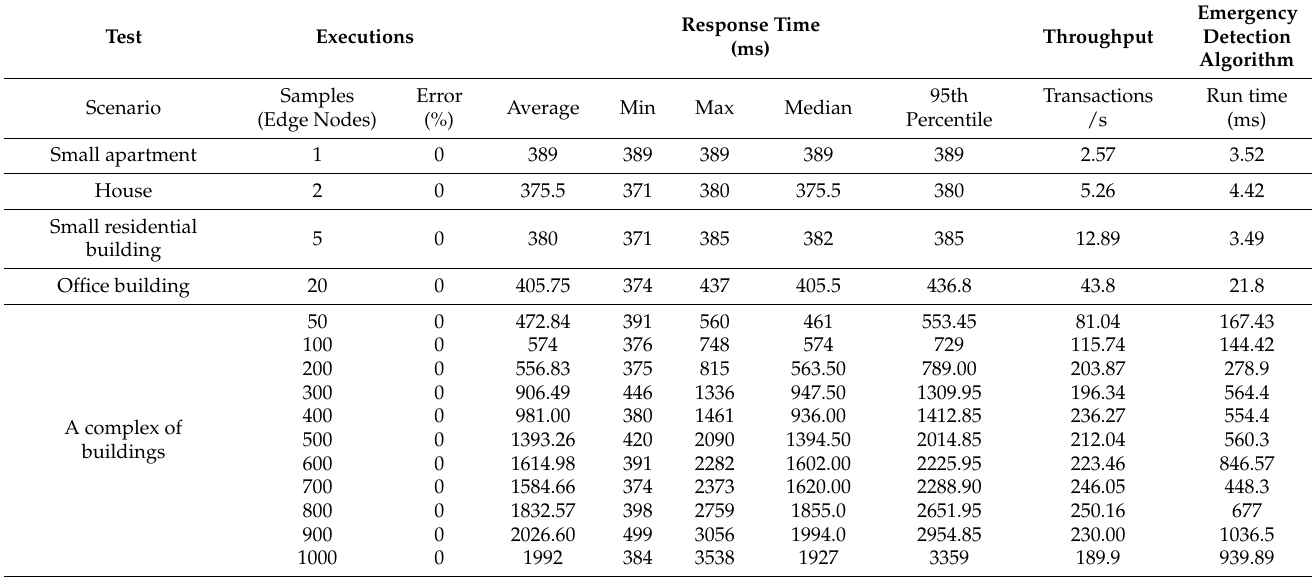
Table 1. Summary of the test results for the IBM Cloud Kubernetes cluster.